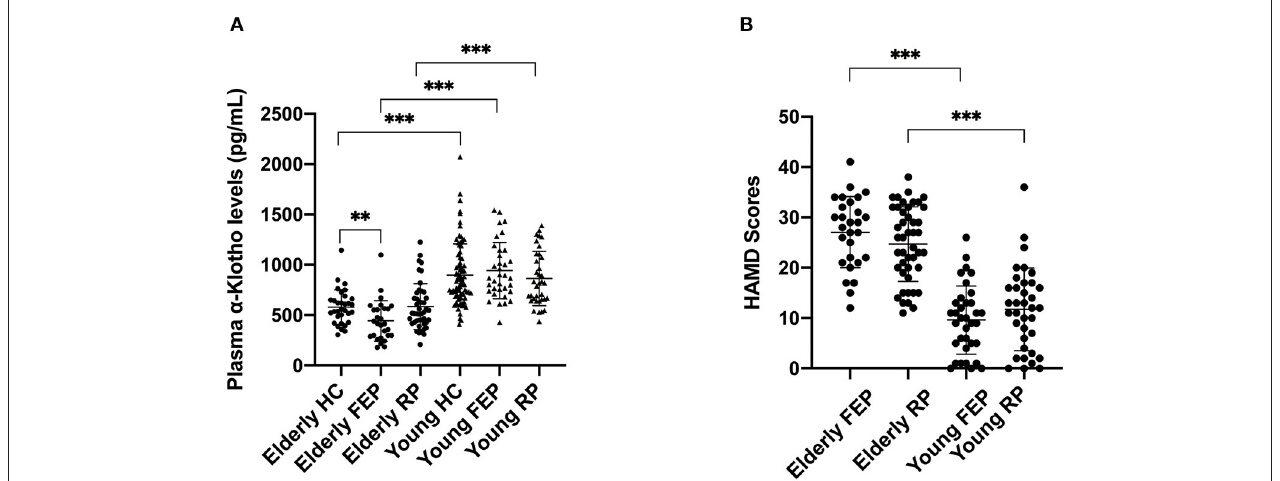
FIGURE 1 | Plasma α -Klotho levels (A) and HAMD scores (B) in participants. HC, healthy controls; FEP, first episode patients; RP, recurrent patients; ** P < 0.01, *** P < 0.001.